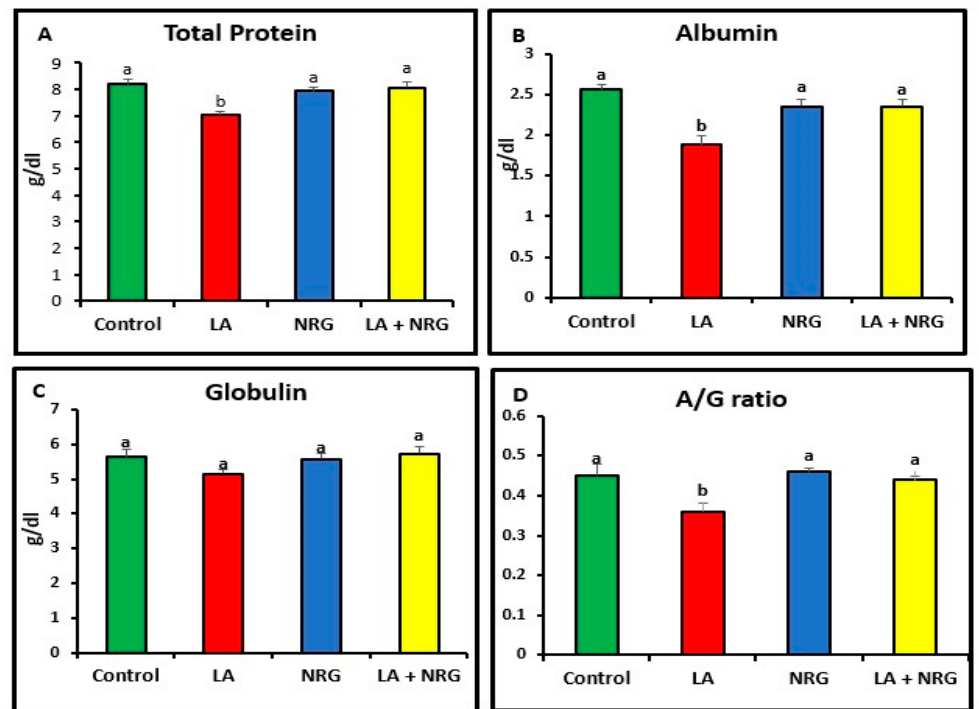
Figure 2. Proteinogram: ( A ) total protein (g/dL), ( B ) albumin (g/dL), ( C ) globulin (g/dL), and ( D ) A/G ratio at the 4th week of treatment of LA-intoxicated rats with NRG (mean ± SE). The means in each chart with different superscripts are significantly different ( p < 0.05). A/G ratio: albumin/globulin ratio. a for the high value; while b for the lower value.